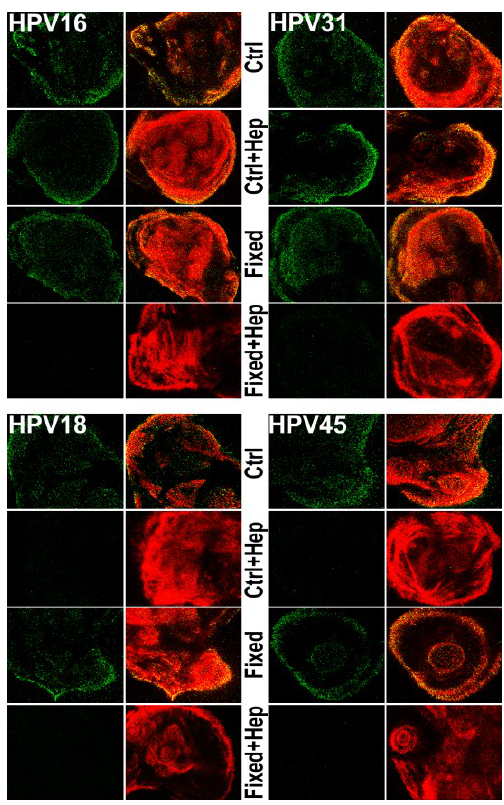
Figure 4. Monitoring viral binding to the ECM in the presence of heparin. Virus was allowed to bind to HaCaT ECM for 1 h at 37 °C. Following fixation, capsids were denatured using a short SDS wash. Virus (green) was then stained with 33L1-7 or a pool of monoclonal antibodies and the ECM (red) was detected using LN332 rabbit polyclonal antibody. Where indicated, the ECM was fixed with 4% PFA prior to viral